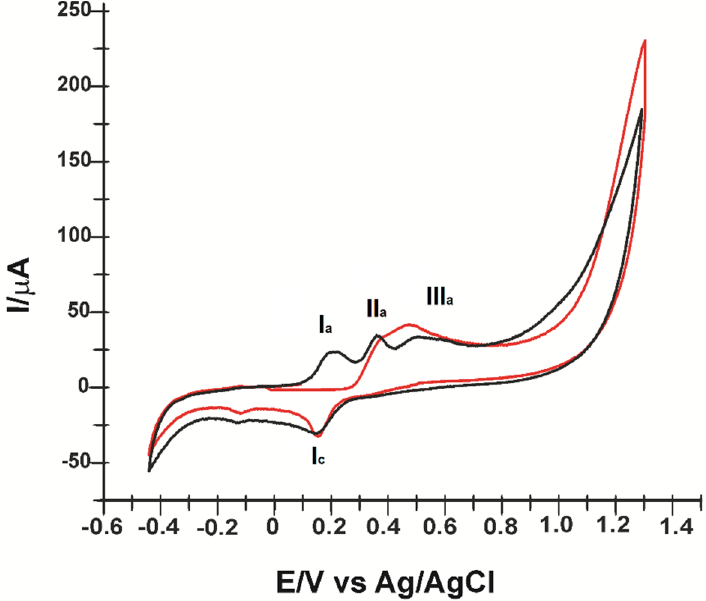
Figure 1. Cyclic voltammogram carbon nanofiber modified screen-printed electrode (CNF/SPE) im- mersed in 10 − 3 M ferulic acid solution and 10 − 1 M PBS at 0.1 V/s: first (red line) and second scan (black